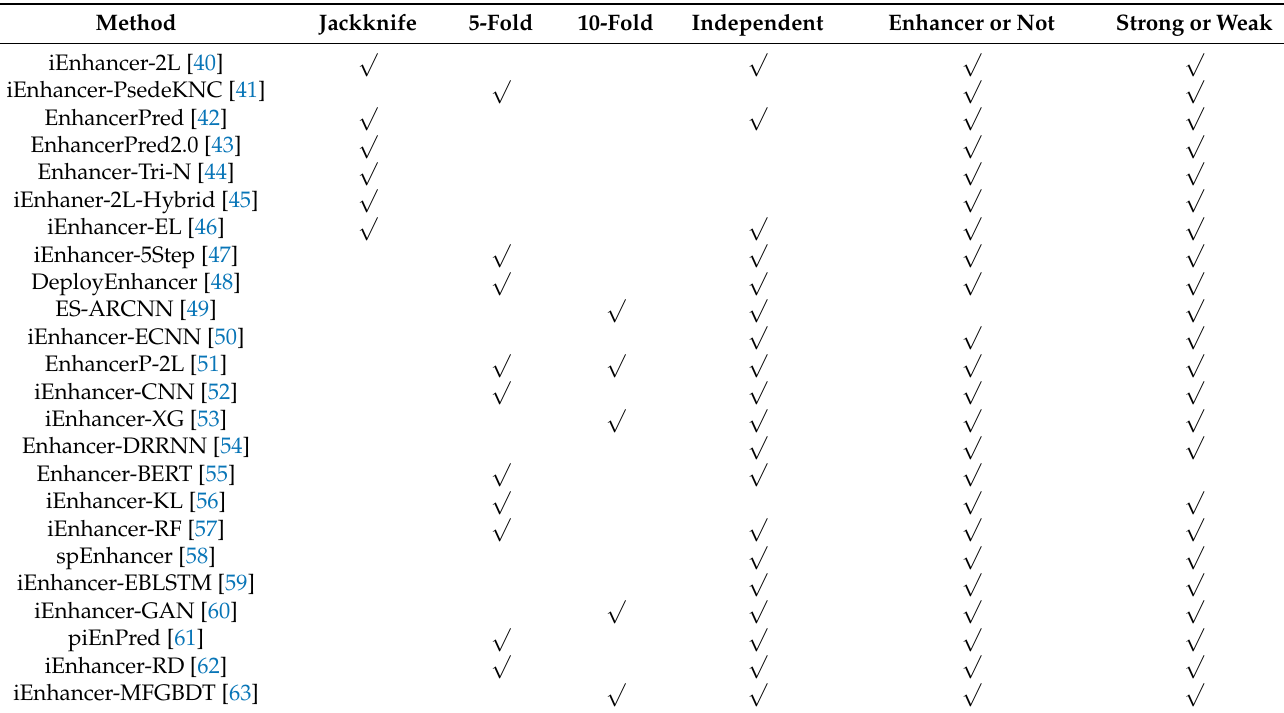
Table 3. Summary of the state-of-the-art methods for predicting enhancers.